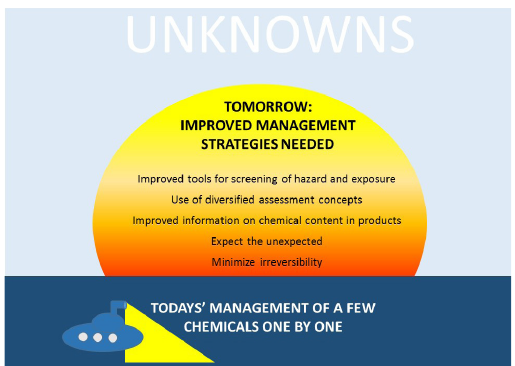
Figure 2. Society’s chemicals management needs to improve in order to reduce risk caused by chemicals in aquatic